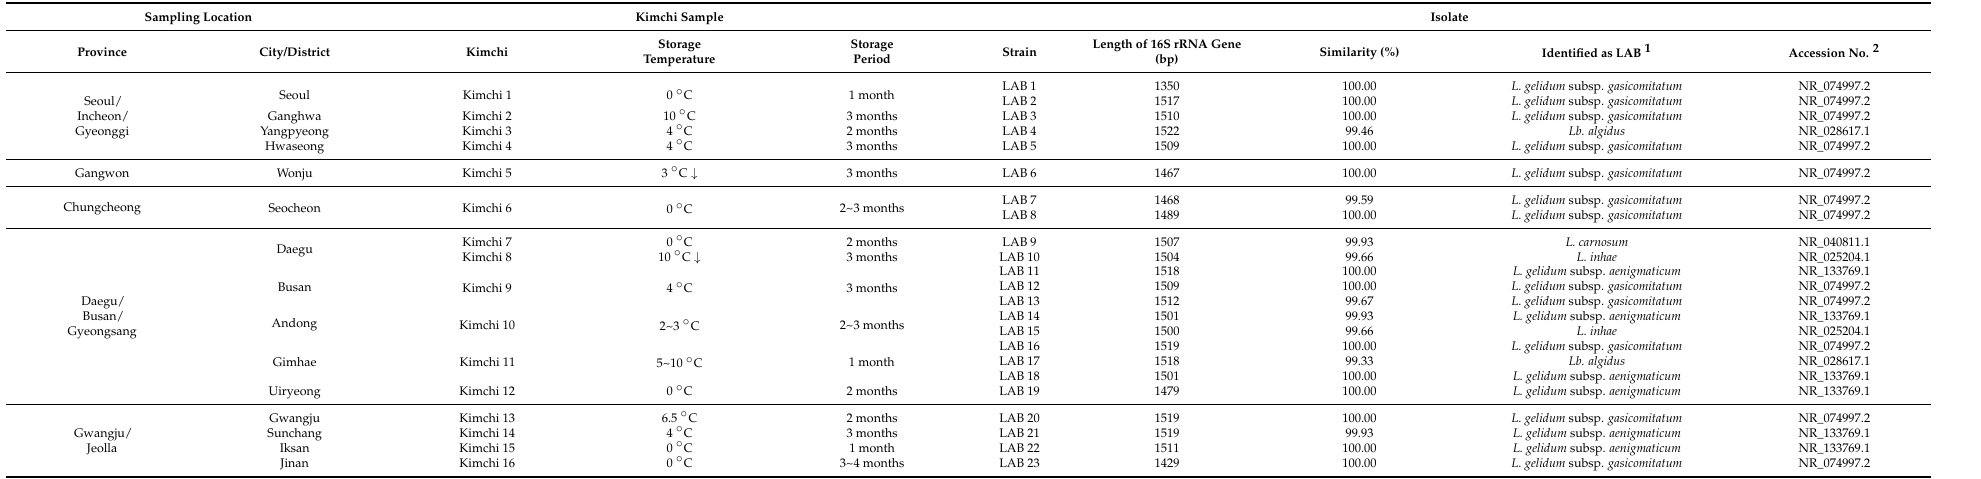
Table 1. Isolation and identification of psychrotrophic LAB from